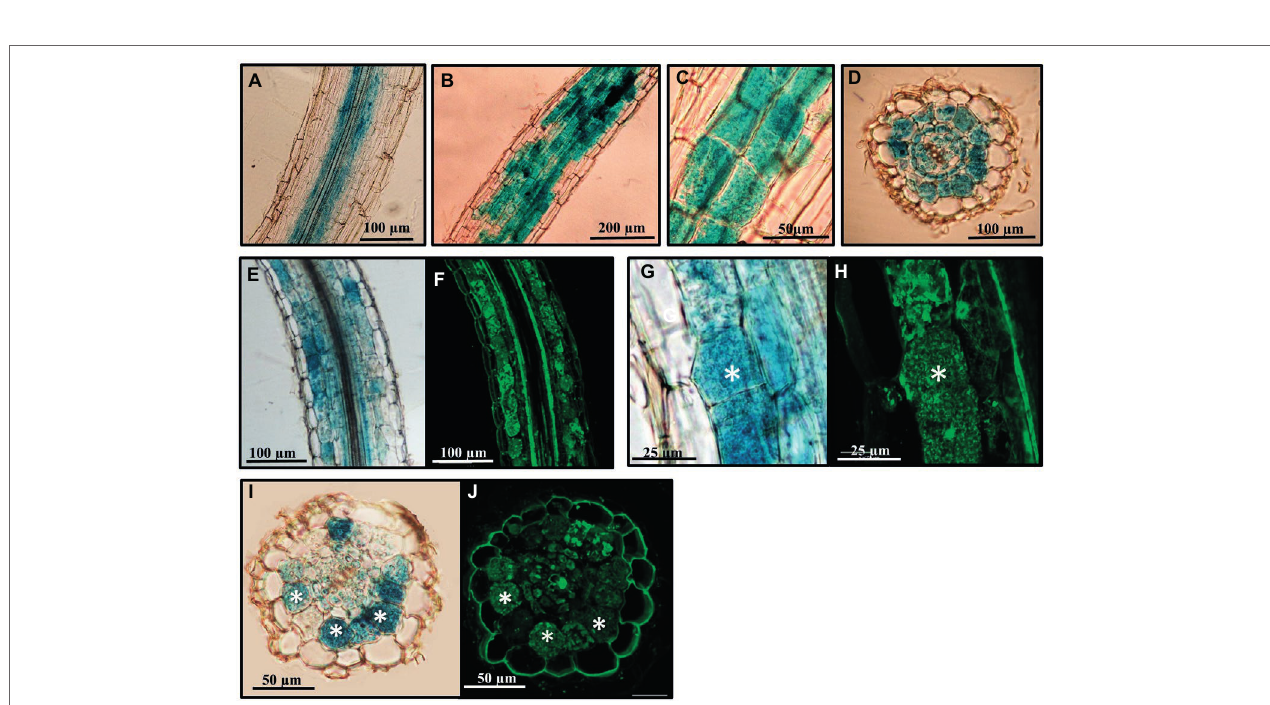
FIGURE 4 | Analysis of the SlGRAS27 promoter activity in transgenic S. lycopersicum roots after GUS staining. GUS activity in sections of A. rhizogenes - transformed roots expressing the p SlGRAS27 :GUS fusion. (A) Non-inoculated root. (B–J) Transformed roots 8 weeks after inoculation with R. irregularis . (F,H,J) Images corresponding to root sections from (E) , (G) , and (J) , respectively, co-stained with WGA-Alexa Fluor 488, which labels the AM fungus and fluoresces green. White asterisks indicate arbuscules in the host cortical cells.